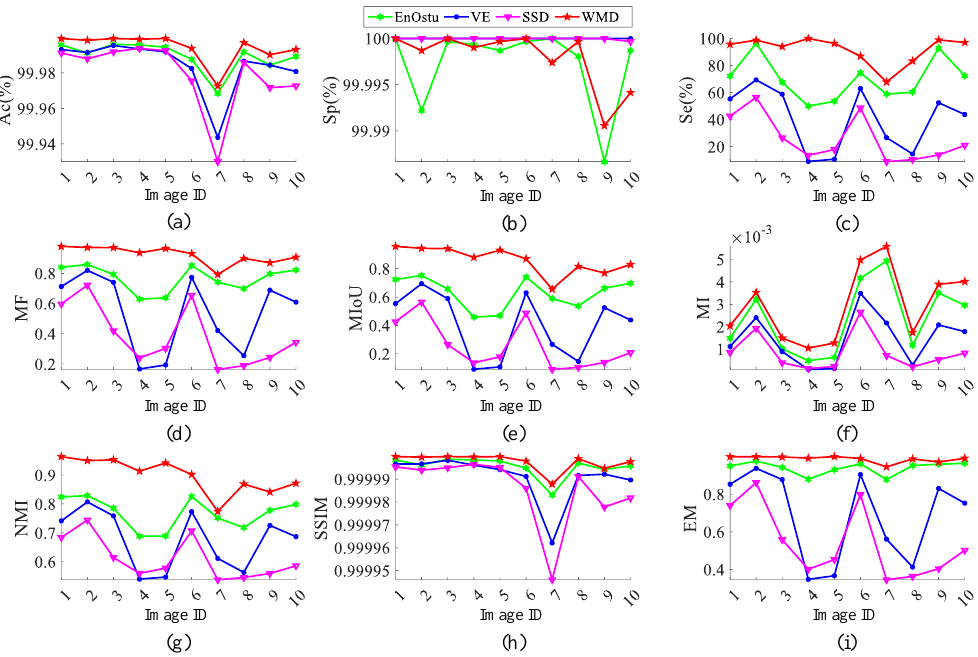
Figure 18. Quantitative comparison in terms of ( a ) Ac (%), ( b ) Sp (%), ( c ) Se (%), ( d ) MF , ( e ) MIoU , ( f ) MI , ( g ) NMI , ( h ) SSIM , and ( i ) EM , where the x axis is the Image ID. Our method outperforms the baseline